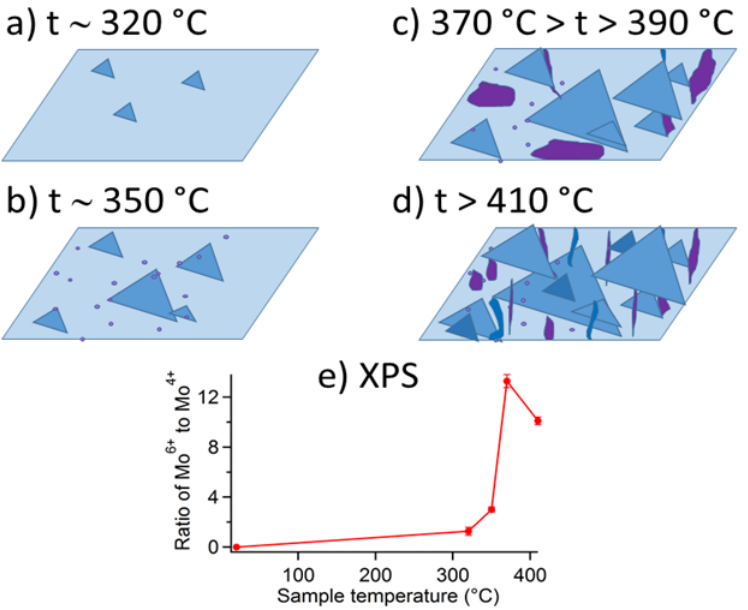
Figure 2. Phenomenological aspects of the MoO x formation onto MoS 2 basal planes during their heating in dry air. ( a ) Above ca. 320 °C, triangular 1 ML deep etch pits were observed [33 – 35,40]. ( b ) Nucleated growth of the etch pits was supplemented by appearance of small sub-nm size MoO x clusters detected already at ca. 350 °C via a combination of various experimental techniques [47]. ( c ) At temperatures between 370 and 390 °C, the largest amounts of Mo oxides and their derivatives accumulate on the MoS 2 surface [42]. Some of it forms irregular patches (marked in violet) [34,42]. ( d ) Above 410 °C, less oxide has been detected indirectly and locally via AFM techniques, as well as chemically and globally via XPS studies. In addition, in this regime, substantial surface defects have been observed. ( e ) Unpublished analysis based on the XPS results (from Reference [42]) collected on Si substrates with sparsely distributed and mechanically exfoliated 2H MoS 2 flakes. It suggests the largest amount of the surface presents MoO 3 oxides in the vicinity of 370 °C.